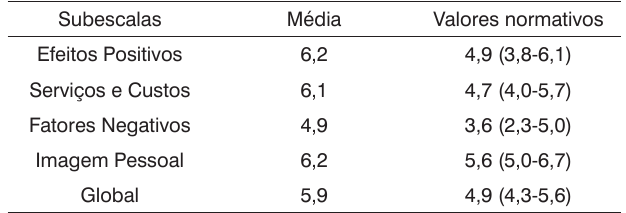
Tabela 1. Correlação entre idade e satisfação global e por subescalas de pacientes protetizados na Clínica Lumiar e avaliados entre setembro e outubro de 2011.